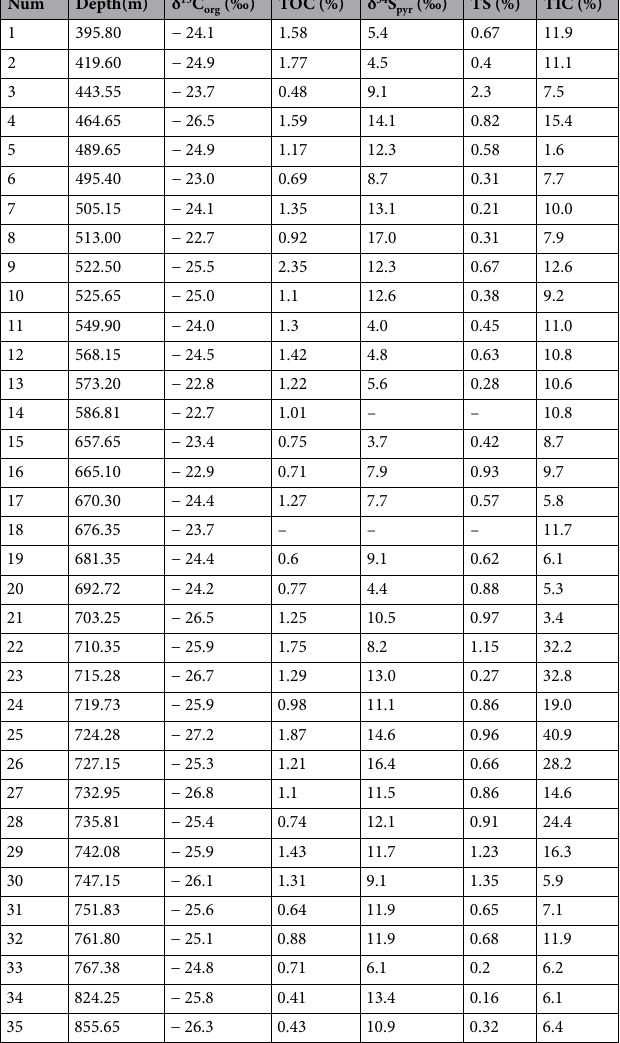
Table 1. Stable carbon isotope (δ 13 C org ), total organic carbon (TOC), total inorganic carbonate (TIC), pyrite sulfur isotopes (δ 34 S py ), and total sulfur (TS) data of the Xiahuapidianzi Formation samples from Hongmiaozi